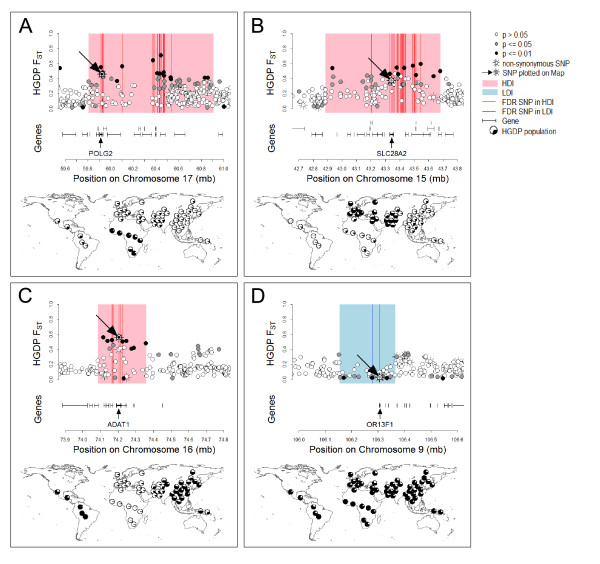
Examples of genomic islands. Each panel shows a genomic island that includes a significantly differentiated non-synonymous SNP. On top, the HDI or LDI is shown in details with all the SNPs and genes located in that region. SNPs are coloured according to their significance level in the selection test and FDR-SNPs are indicated by red vertical lines. The oblique arrow points at the non-synonymous SNP, and the vertical arrow indicates the gene embedding this SNP. The allele frequencies of the non-synonymous SNP in the HGDP populations are shown on the map below. Most common patterns of significant differentiation are found between continental groups, such as African vs. non-Africans (A), between Eurasian vs. non-Eurasians (B), or between East Asian and American vs. African and Eurasian populations (C). SNPs in low-differentiation islands tend to have similar allele frequencies in all populations (D).